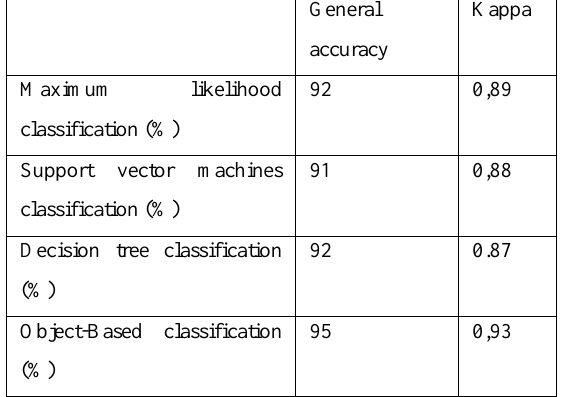
Chart 2. Classification results obtained from the pan sharpened